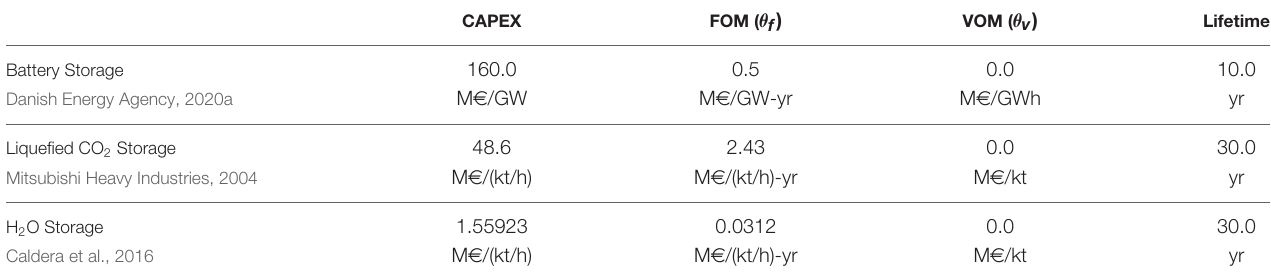
TABLE 5 | Economic parameters used to model storage nodes (flow component, 2030